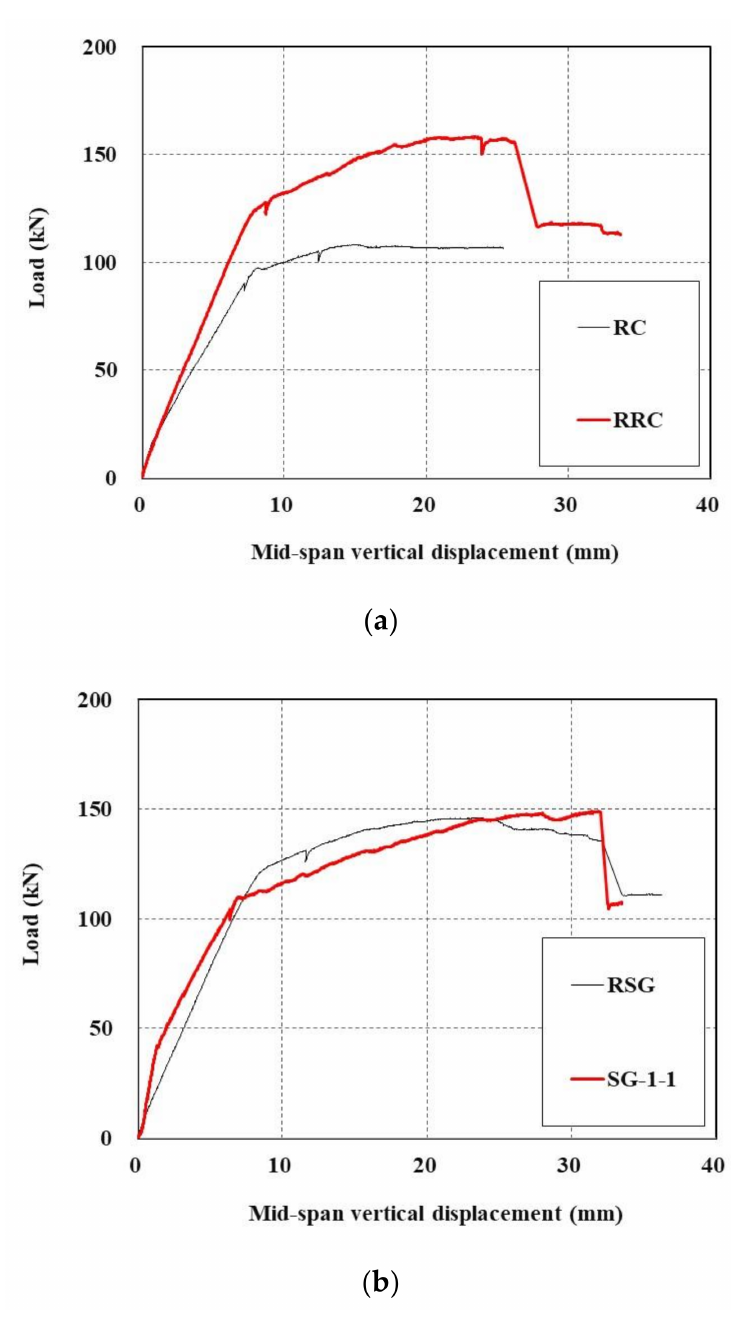
Figure 14. Load-displacement curves of damaged RC slabs re-strengthened with TRC system: ( a ) RC [16] and RRC; ( b ) SG-1-1 [16] and